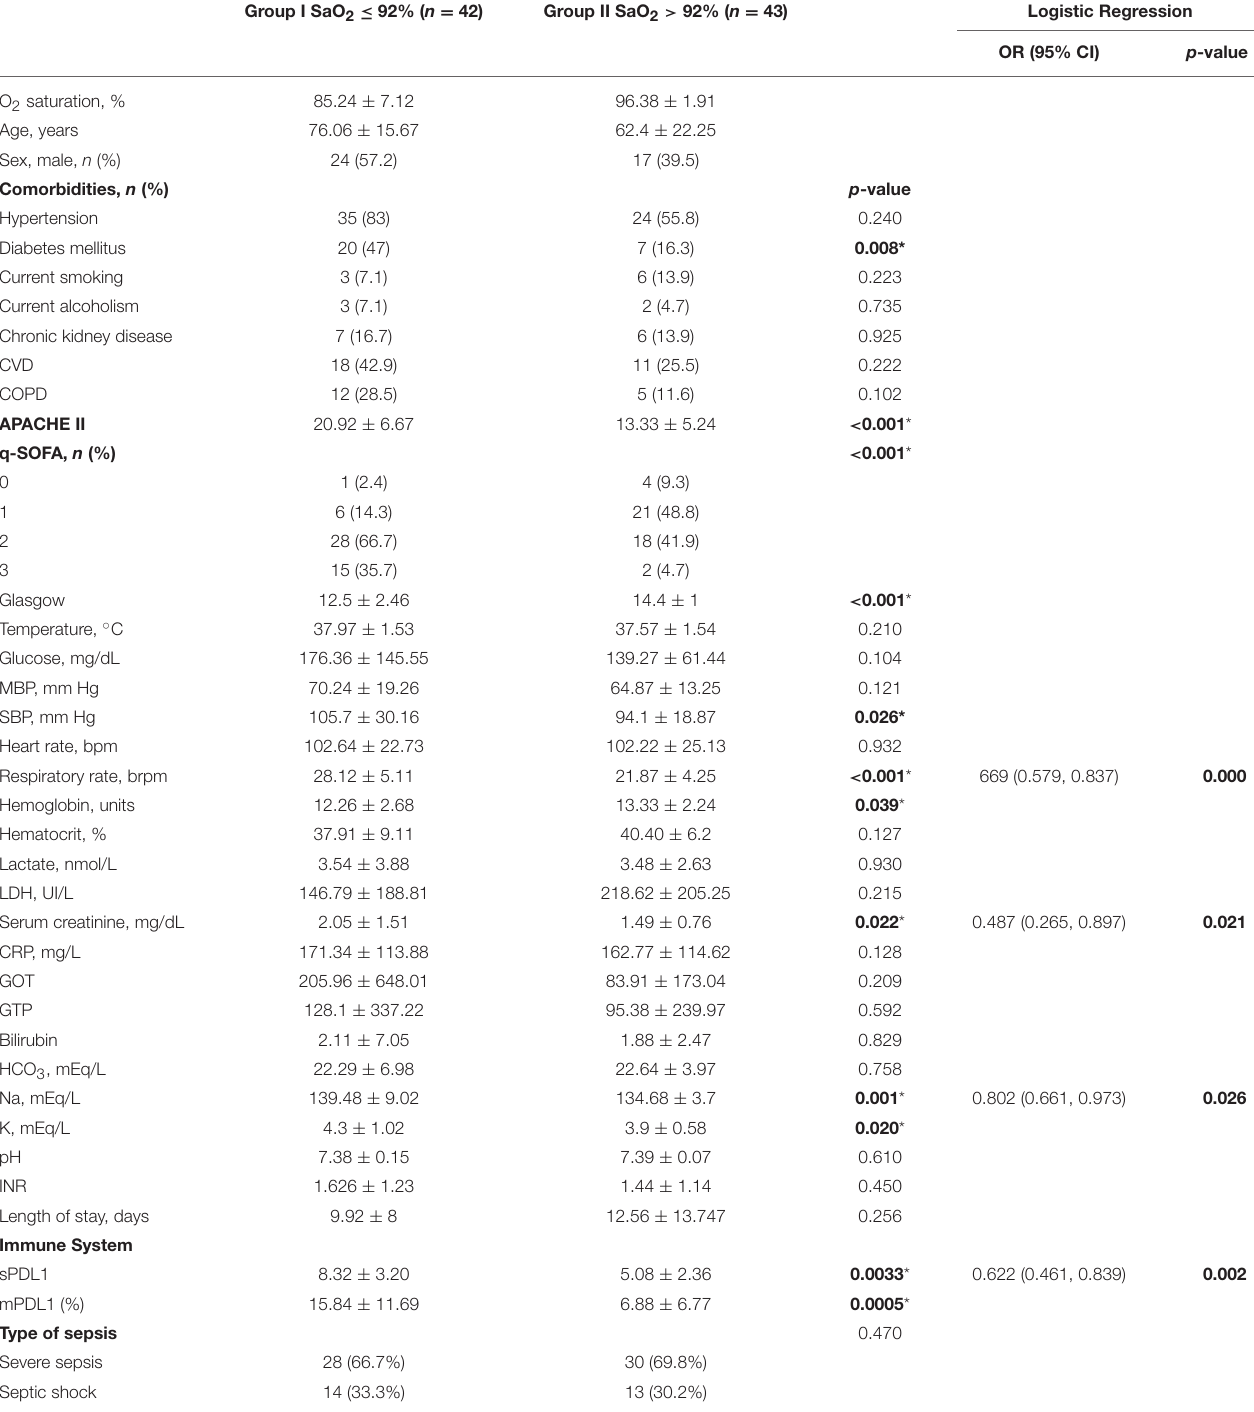
TABLE 1 | Patient